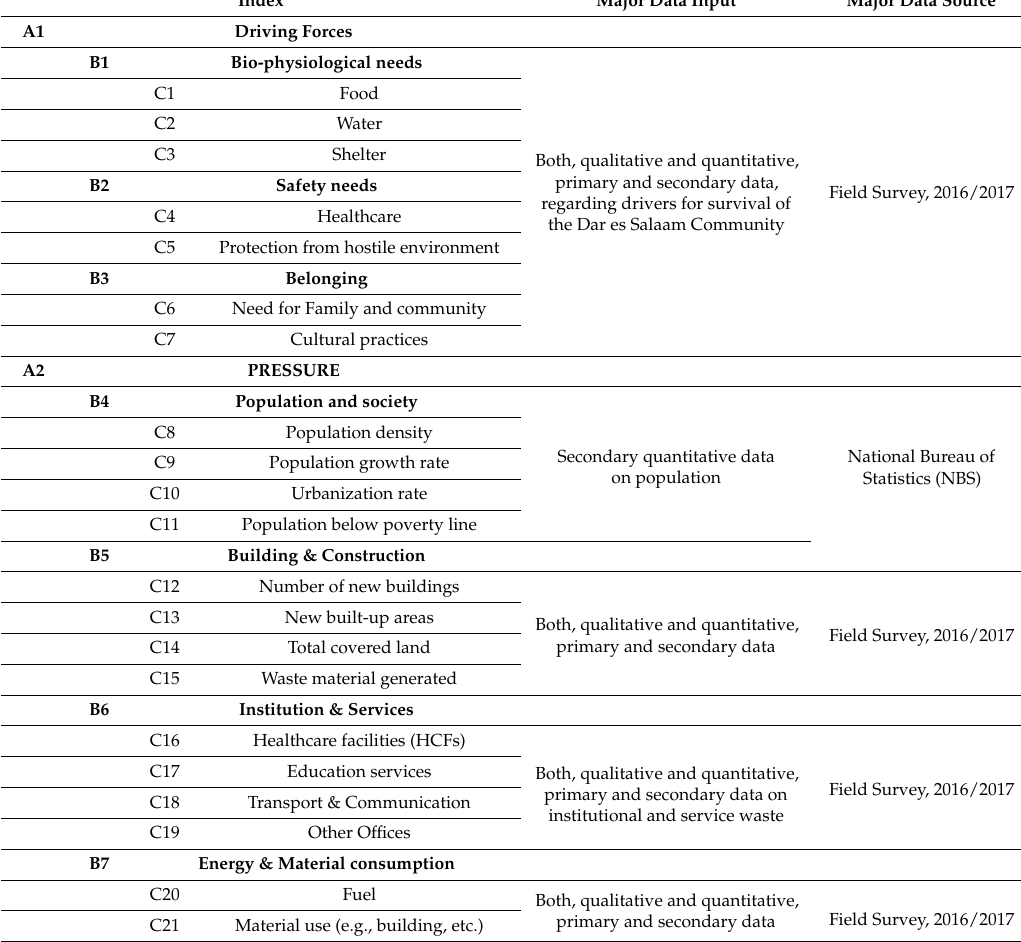
Table A1. Environmental Risk Indicator System for Dar es Salaam MSW and Data